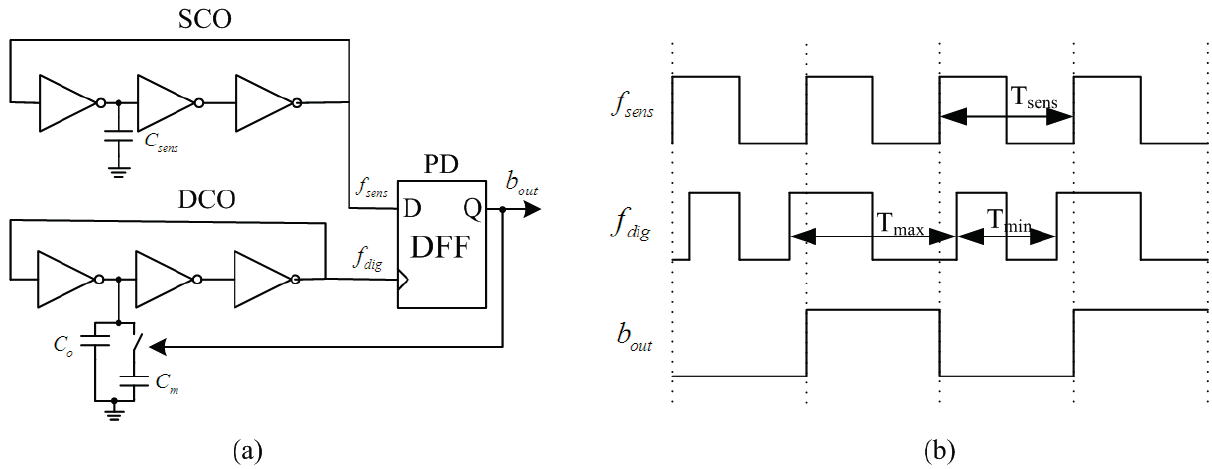
Figure 6. Proposed fully-digital capacitive sensor interface; ( a ) architecture; ( b ) corresponding waveforms for a constant sensor